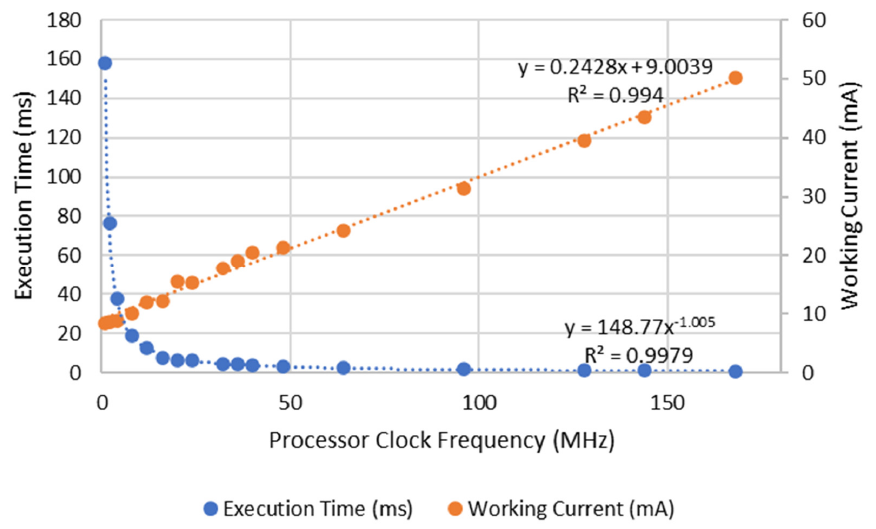
Figure 7. The relation between the execution time, the working current of the whole core board, and the processor fre- quency.